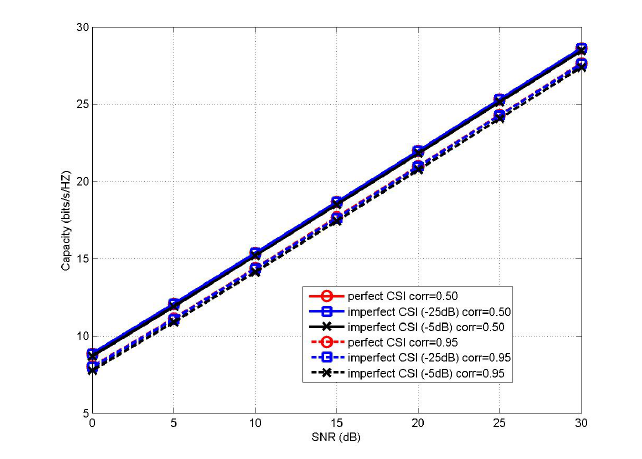
Figure 6. Channel capacity performance comparison between the proposed MLCNN in imperfect CSI and perfect CSI for ( 32,32;2,32 ) MIMO IoT system under correlation coefficients of corr = 0.50 and